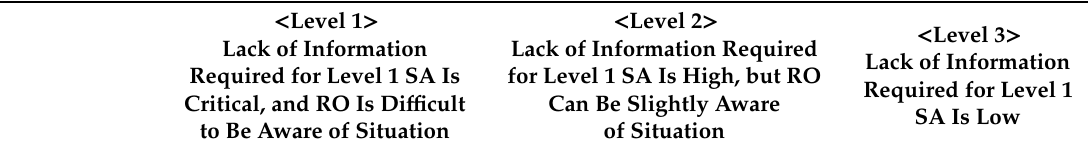
Table 7. Relationship between lack of ship sense and lack of required information for Level 1